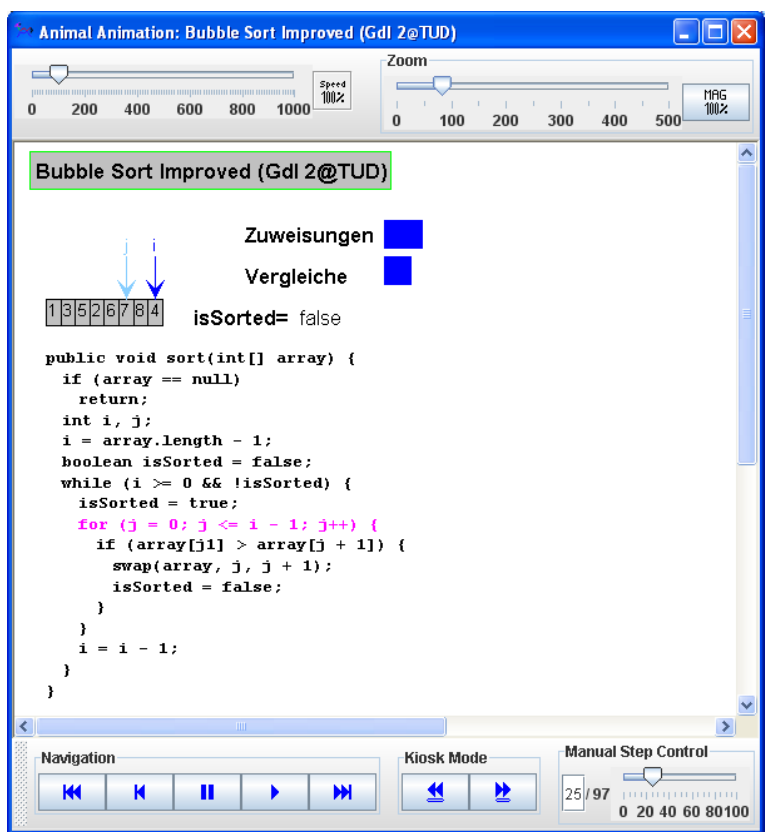
Figure 5. Example screenshot from the A NIMAL user front-end animating